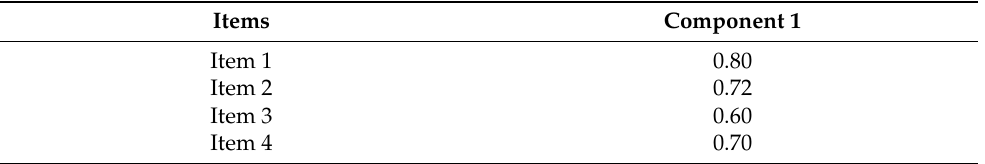
Table 5. The result of the exploratory factor